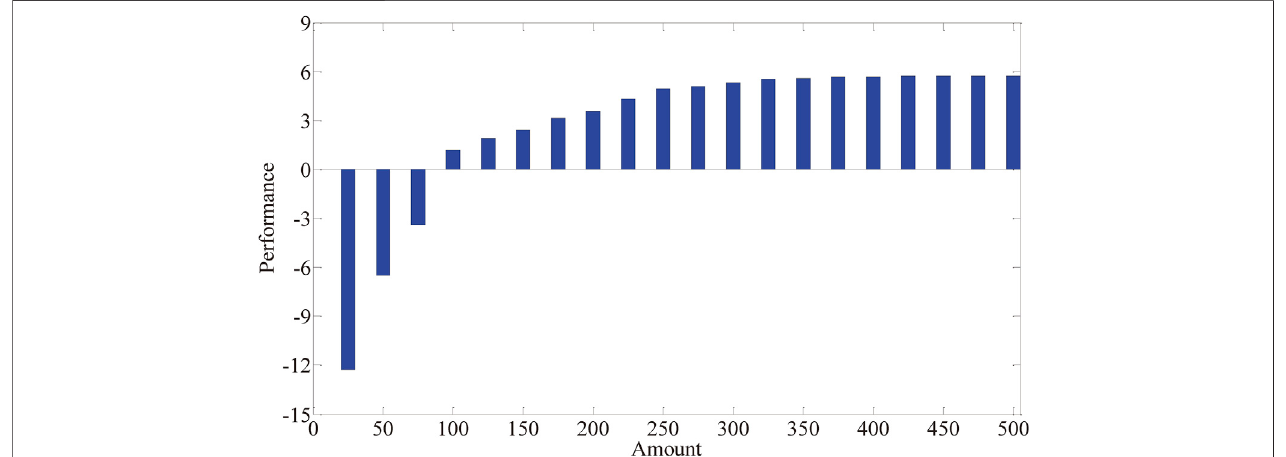
FIGURE 8 | In fl uence of the EV sample size on the recognition effect.